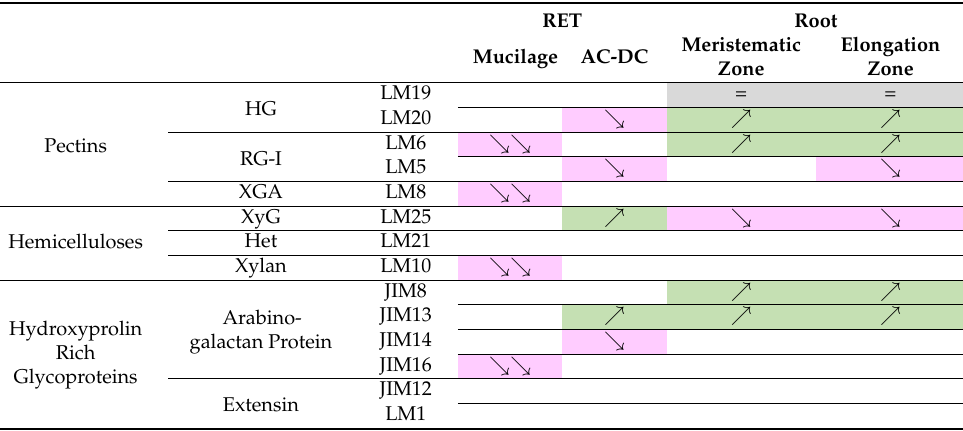
Table 2. Modification of glycopolymer immunolabeling in P. nigra RET and root tips in response to osmotic stress. AC-DC: root associated cap derived cell, HG: homogalacturonan, RET: root extracellular trap, RG-I: rhamnogalacturonan I, XGA: xylogalacturonan, XyG: xyloglucan, Het: heteromannan. = : Same labeling under osmotic stress, (cid:37) : increased labeling under osmotic stress, (cid:38) decreased labeling under osmotic stress, (cid:38)(cid:38) : loss of labeling under osmotic stress, white square: no labeling either under control conditions or under osmotic stress